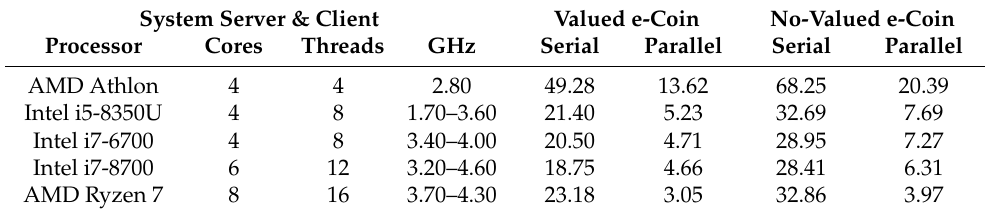
Table 1. “E-coin generation” running times (in milliseconds).